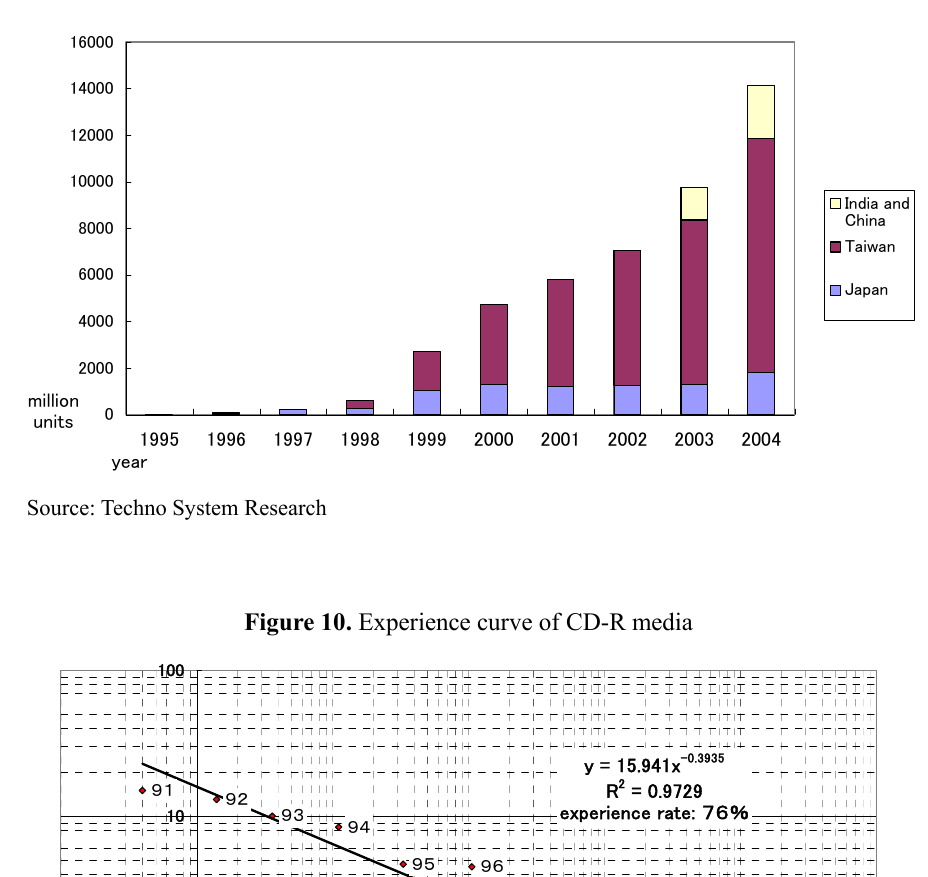
Figure 9. Trend of writable optical storage media production by nationality